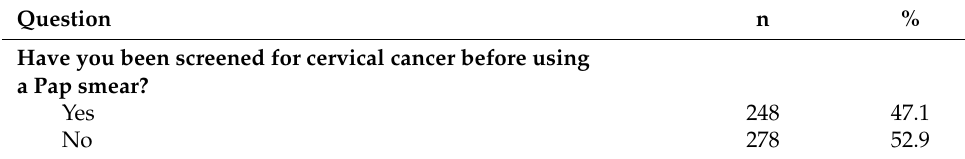
Table 4. Screening history and knowledge about cervical cancer risk